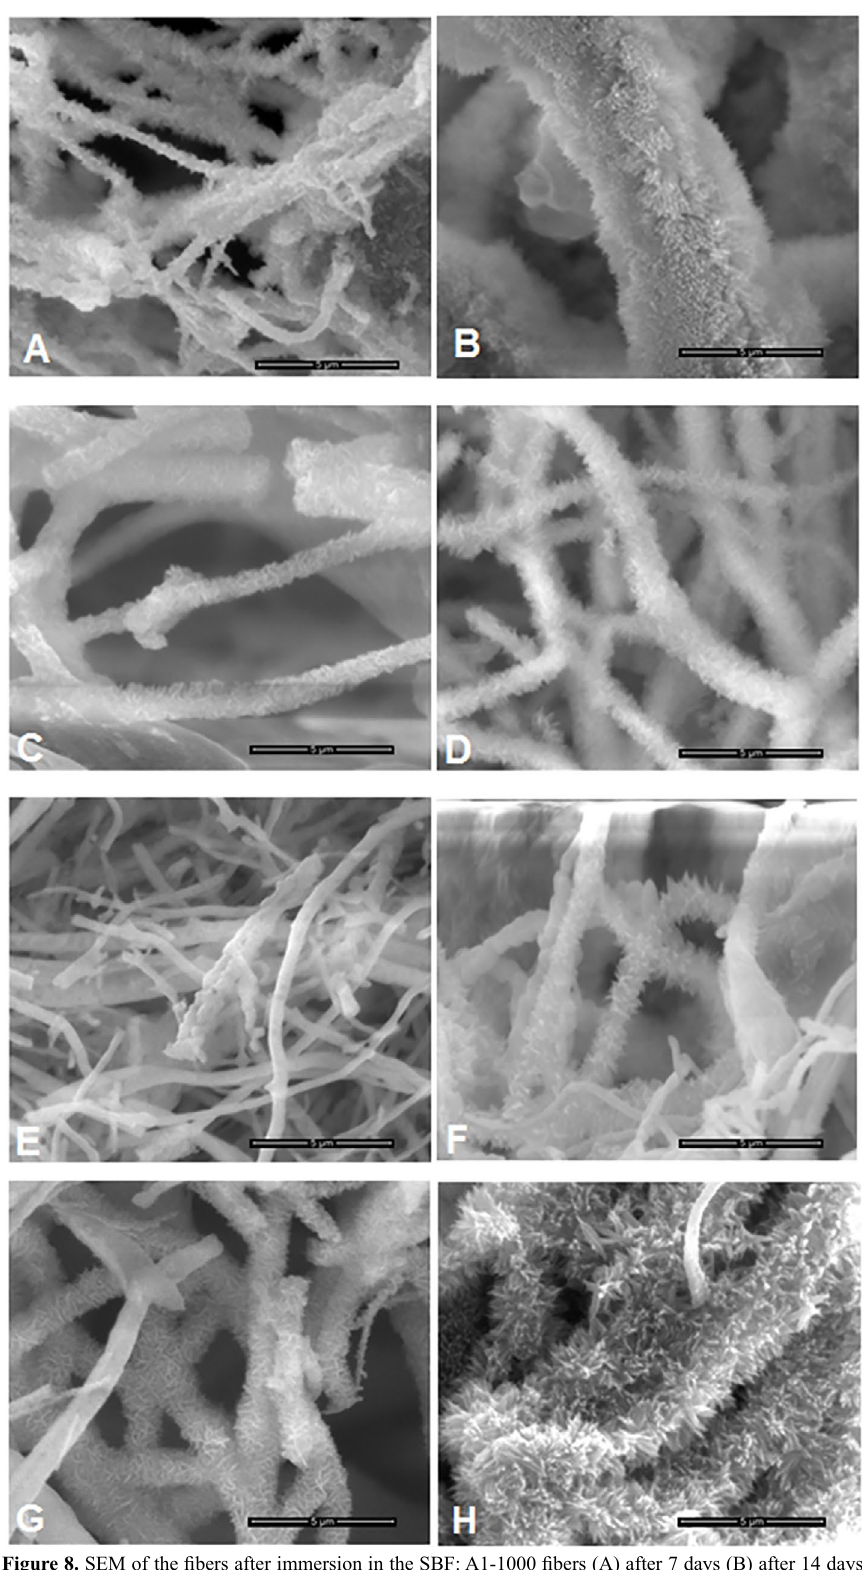
Figure 8. SEM of the fibers after immersion in the SBF: A1-1000 fibers (A) after 7 days (B) after 14 days, A1-900 fibers (C) after 7 days (D) after 14 days, A075-1000 fibers (E) after 7 days (F) after 14 days, A075-900 fibers (G) after 7 days (H) after 14